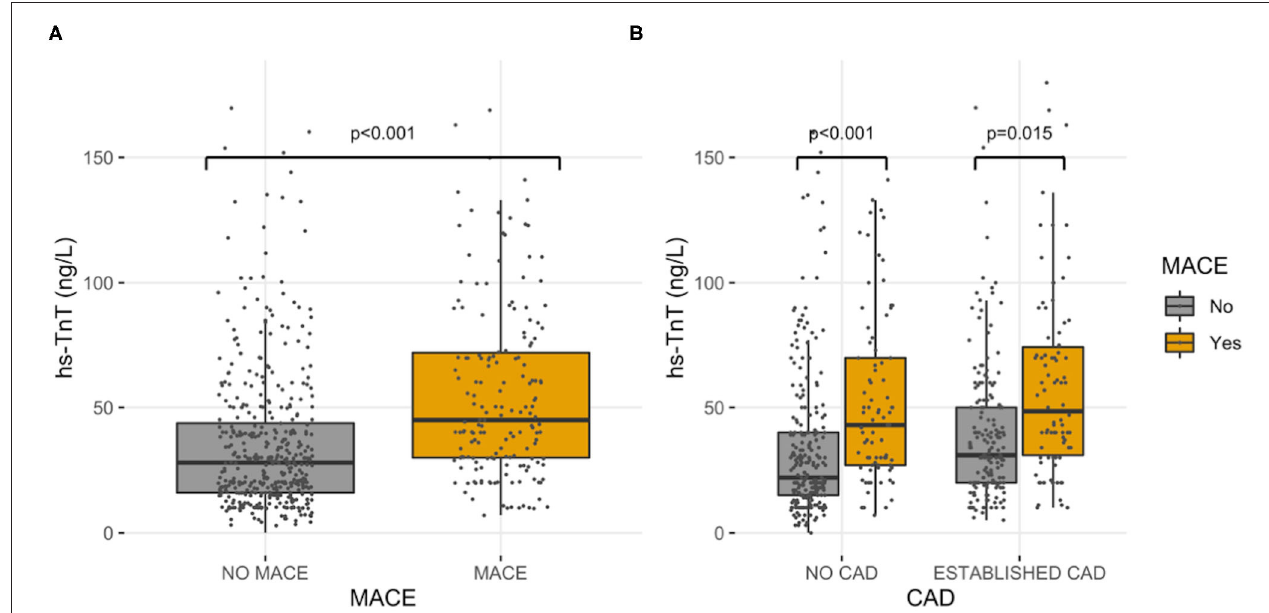
FIGURE 2 | High-sensitivity cardiac troponin T values. Hs-TnT values, grouped by MACE, in the entire study population (A) and in established CAD and no CAD diagnosis sub-cohorts (B) .